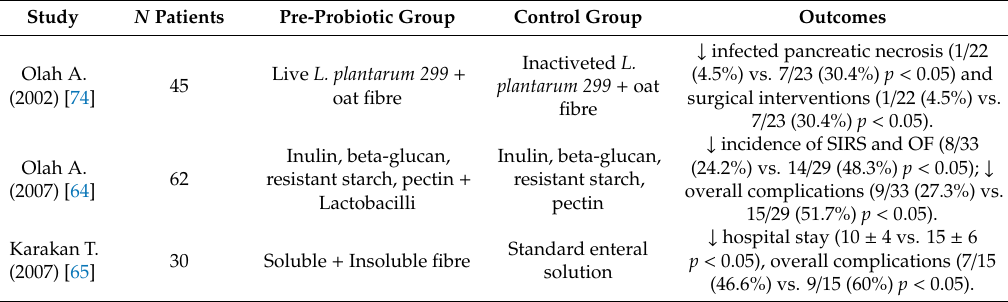
Table 2. E ff ects of pre- and probiotic supplementation in enteral nutrition on acute pancreatitis.